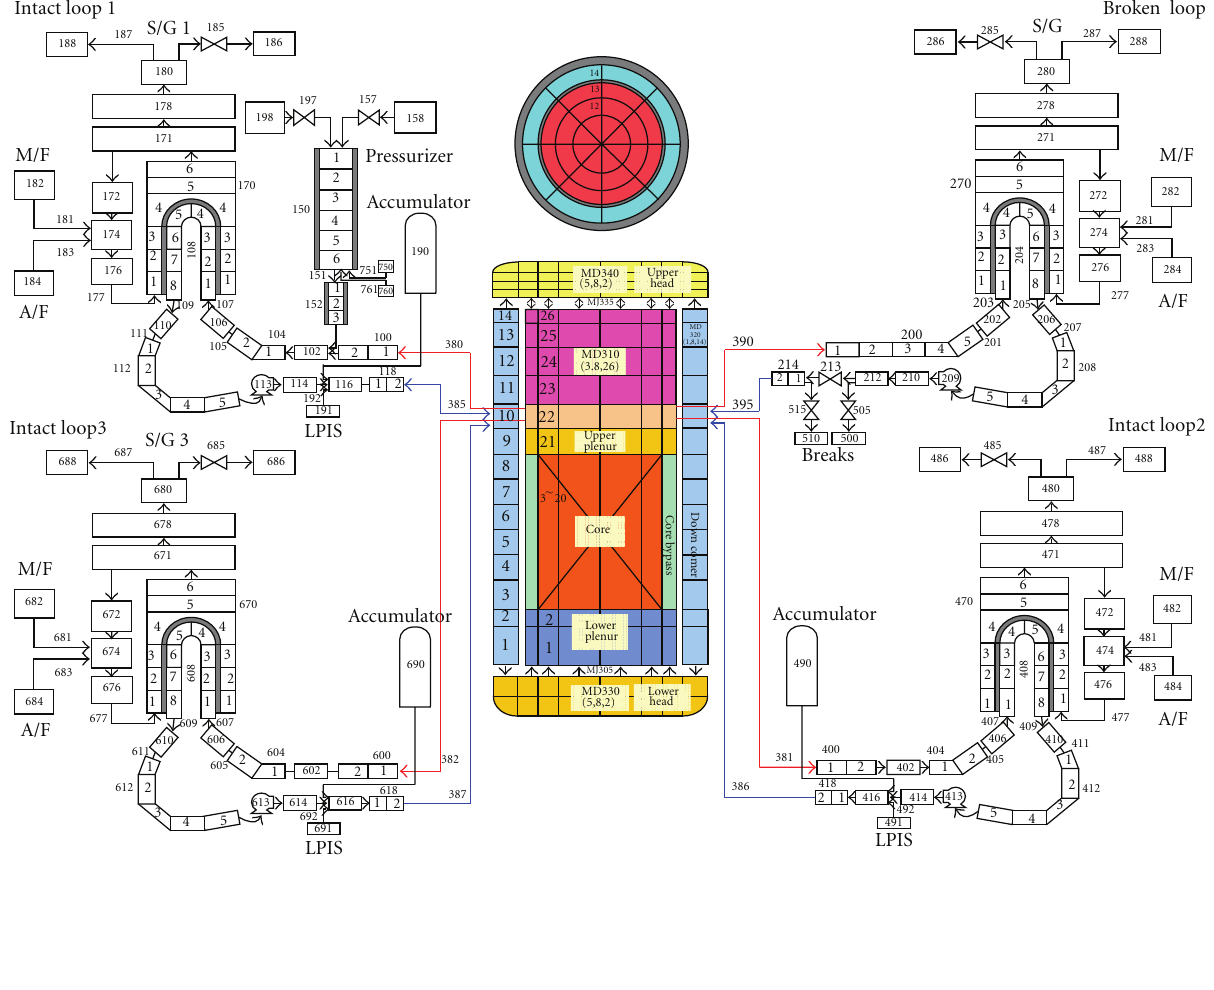
Figure 3: Example of 3-D MARS vessel nodalization scheme used by